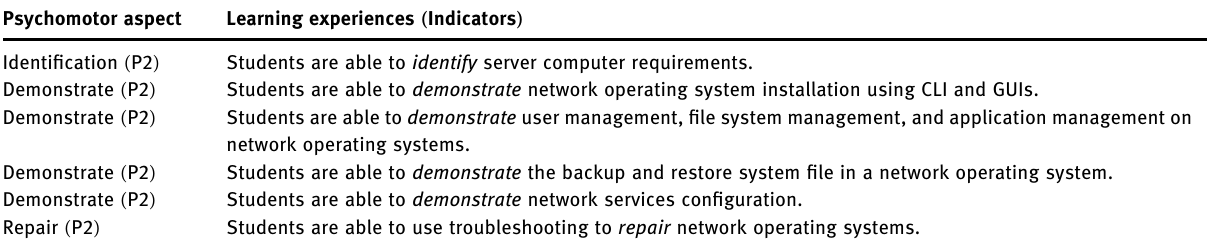
Table 1: Psychomotor competency achievement indicators Psychomotor